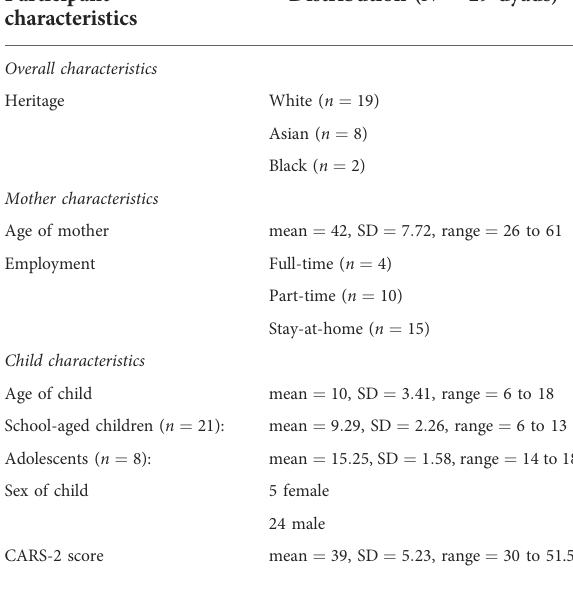
TABLE 2 Participant characteristics. Participant characteristics